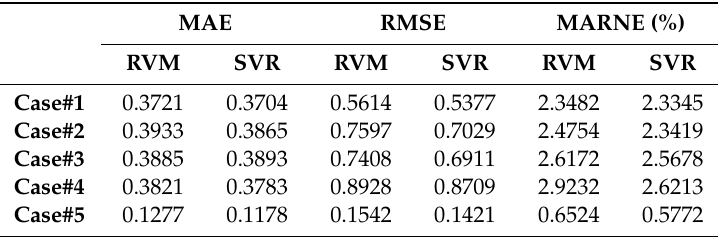
Table 4. Evaluation of Relevance Vector Machine (RVM) and Support Vector Regression (SVR) considering the 1-min-ahead horizon.